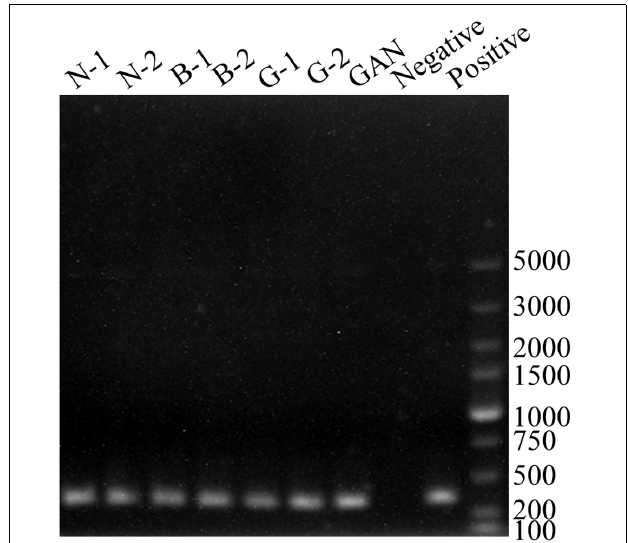
FIGURE 3 | PCR results for genes involved in BAs degradation. PCR products using the primer pair BCf/BCr for identification of multi-copper oxidase gene.